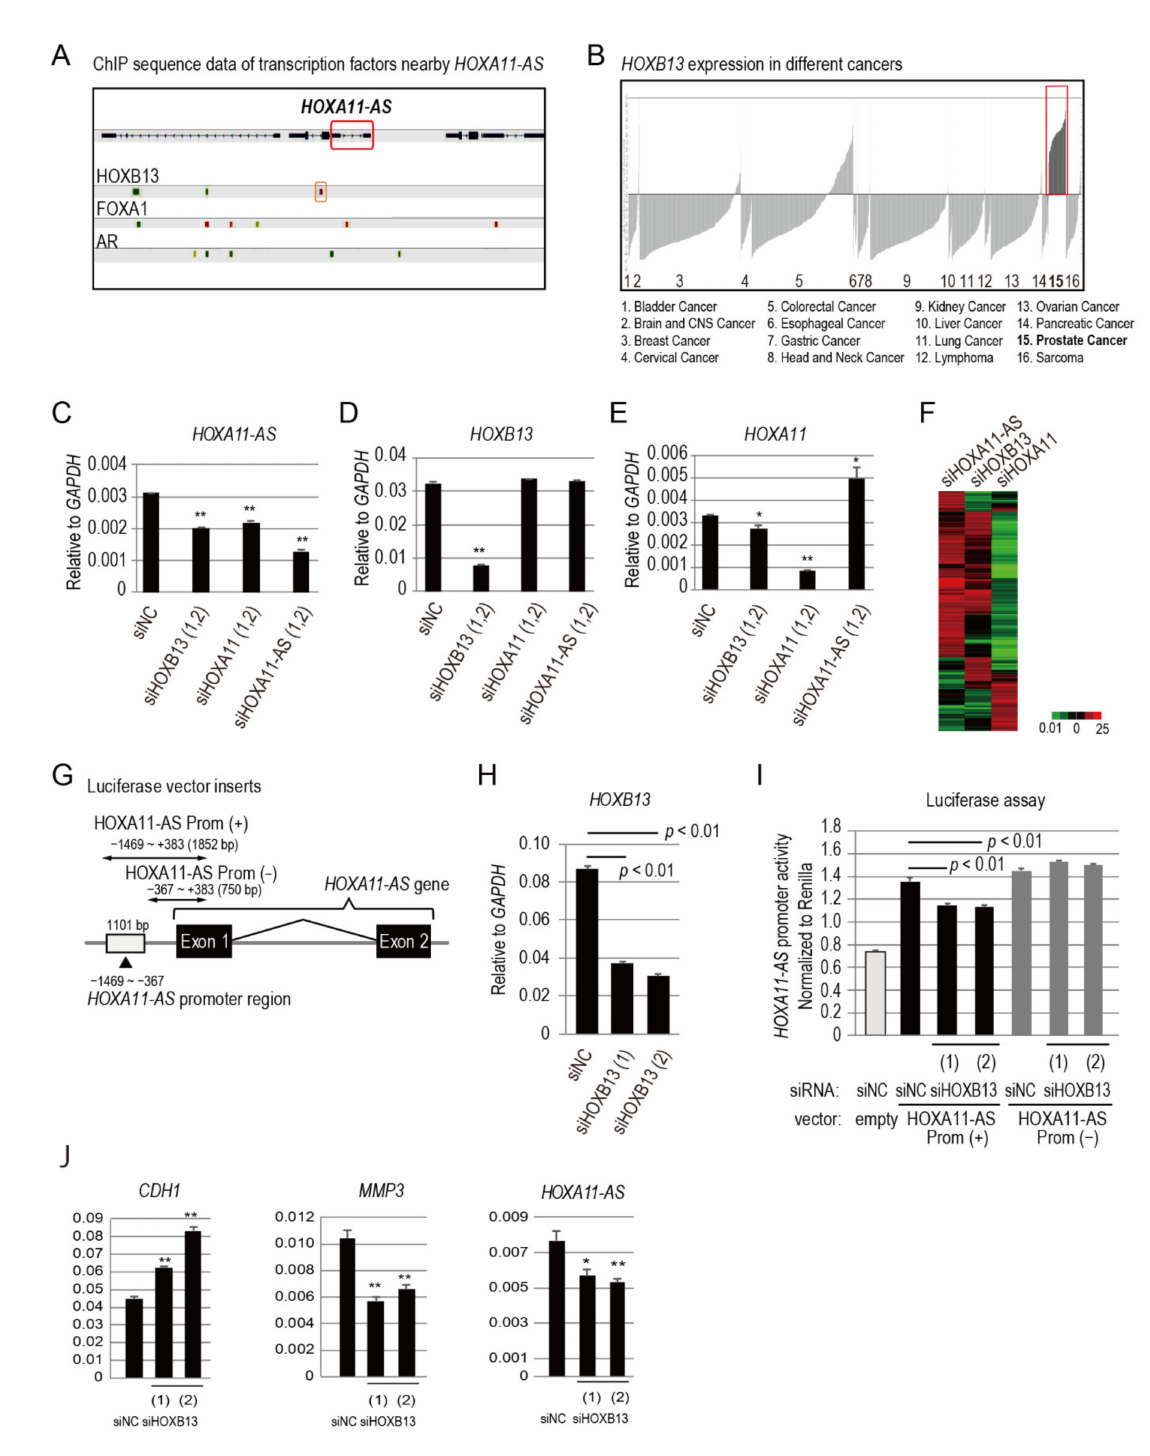
Figure 2. HOXB13 is an upstream regulator of HOXA11-AS . ( A ) Analysis of HOXB13 (orange box) and AR binding sites near HOXA11-AS gene (red box) using ChIP-Atlas database (https://chip-atlas.org/). The colors of peaks indicate the statistical significance values calculated by the peak-caller MACS2 (MACS2 scores). ( B ) Analysis of HOXB13 gene expression levels in 16 different cancers using Oncomine database (https://www.oncomine.org/resource/login.html). HOX13 expression levels in prostate cancer are indicated by a red box. Values on y -axis indicate log2 median-centered intensity, which ranges from 6.5 to − 5.0. ( C – E ) Expression analysis by qPCR of PC3 cells transfected for 48 h with siRNAs targeting HOXA11-AS , HOXB13 , and HOXA11 . ( F ) Microarray analysis of PC3 cells transfected with siRNAs. Heatmap represents gene